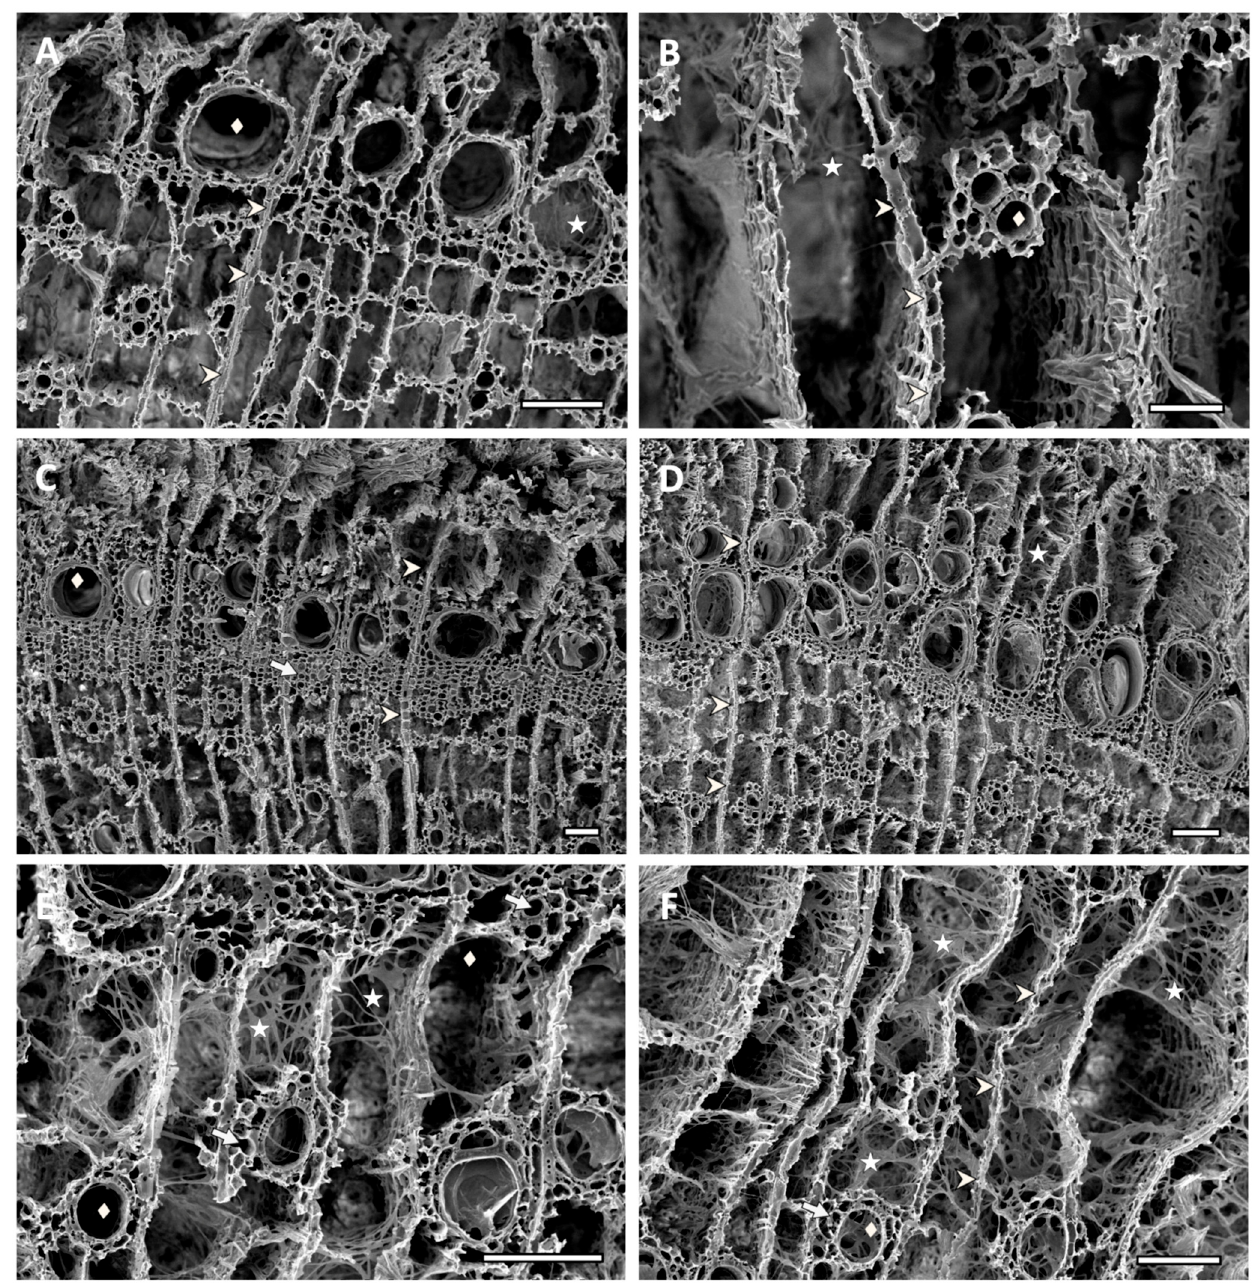
Figure 8. Scanning electron micrographs of transverse sections of ash sapwood disc samples inocu- lated with white-rot fungi. Arrow indicates fibers, arrowhead indicates ray parenchyma, diamond shape indicates vessels and star shape indicates mycelium. ( A , B ) Complete loss of fiber cell walls produced by simultaneous degradation by Trametes versicolor (EAB 43-3). Coalescence of void-created holes, where remnants of adjacent fiber and parenchyma cells attached to the vessels, can be observed. Ray parenchyma cells were eroded, but still distinguishable. Voids filled with mycelia (( A ) bar = 100 µm, ( B ) bar = 50 µm). ( C ) Extended erosion and thinning of fiber cell walls produced by Phlebia radiata (EAB 60-6), and a simultaneous degradation of all cell wall components. Localized collapse of fiber structure and holes produced by coalescing voids. Ray parenchyma cells, vessels and fibers showing erosion are still distinguishable at the center of the image (bar = 100 µm). ( D – F ) Extensive decay produced by Phlebia acerina (EAB 49-10), showing voids filled with mycelia. Ray parenchyma are eroded, but still distinguishable, and for some remaining vessels, remnants of adjacent fiber and parenchyma cells attached to the vessels can be observed (bar = 100 µm).